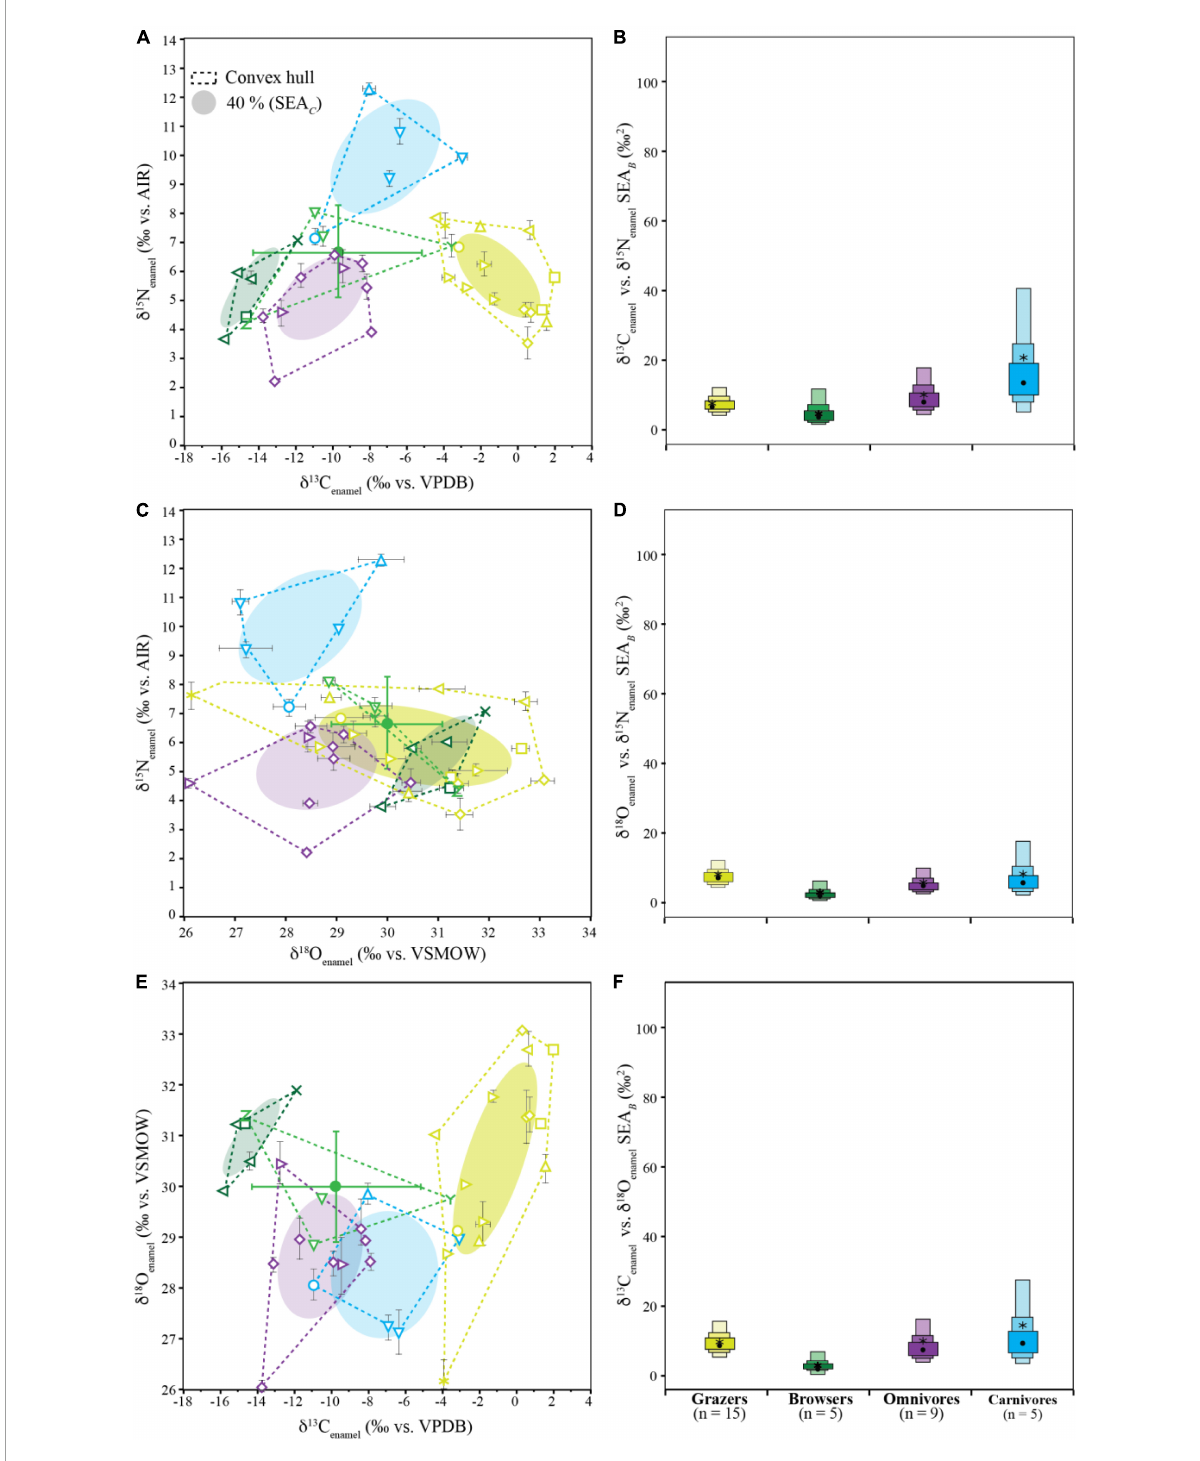
FIGURE7 Biplots (A,C,E) and calculated SEA B boxplots (B,D,F) for δ 13 C enamel vs. δ 15 N enamel (A,B) , δ 18 O enamel vs. δ 15 N enamel (C,D) , and δ 13 C enamel vs. δ 18 O σ standard deviation, convex hulls encompass the full variation in the data, and ellipses enamel (E,F) . Biplots show raw isotope values with 1 indicate 40% estimated SEA C for Gorongosa fauna grouped by diet (light green: grazers; bright green: mixed-feeders; dark green: browsers; purple: omnivores; blue: carnivores; for taxon-specific symbols refer to Figure 2 ). Boxplots show the variability of SEA B , with 50, 75, and 95% credible intervals represented by light, medium, and dark colored boxes, respectively. Black dots are the SEA B mode and stars are the calculated SEA c , which correspond to biplot ellipses. Box plots and SEA C of mixed-feeders are not shown due to their small sample size ( n = 4) instead, their mean values and 1 σ standard deviation are given (green cycle with error